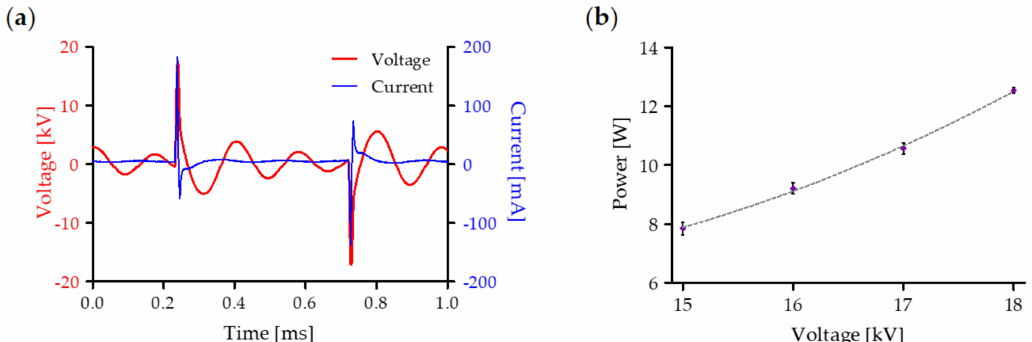
Figure 1. Electrical characterization of plasma source during treatment of Ringer’s Lactate (RL) solution: ( a ) representative voltage (red) and current (blue) waveforms at 18 kV and 1 kHz and ( b ) power values as a function of the applied voltage. Data are presented as mean ± SEM ( n = 3).